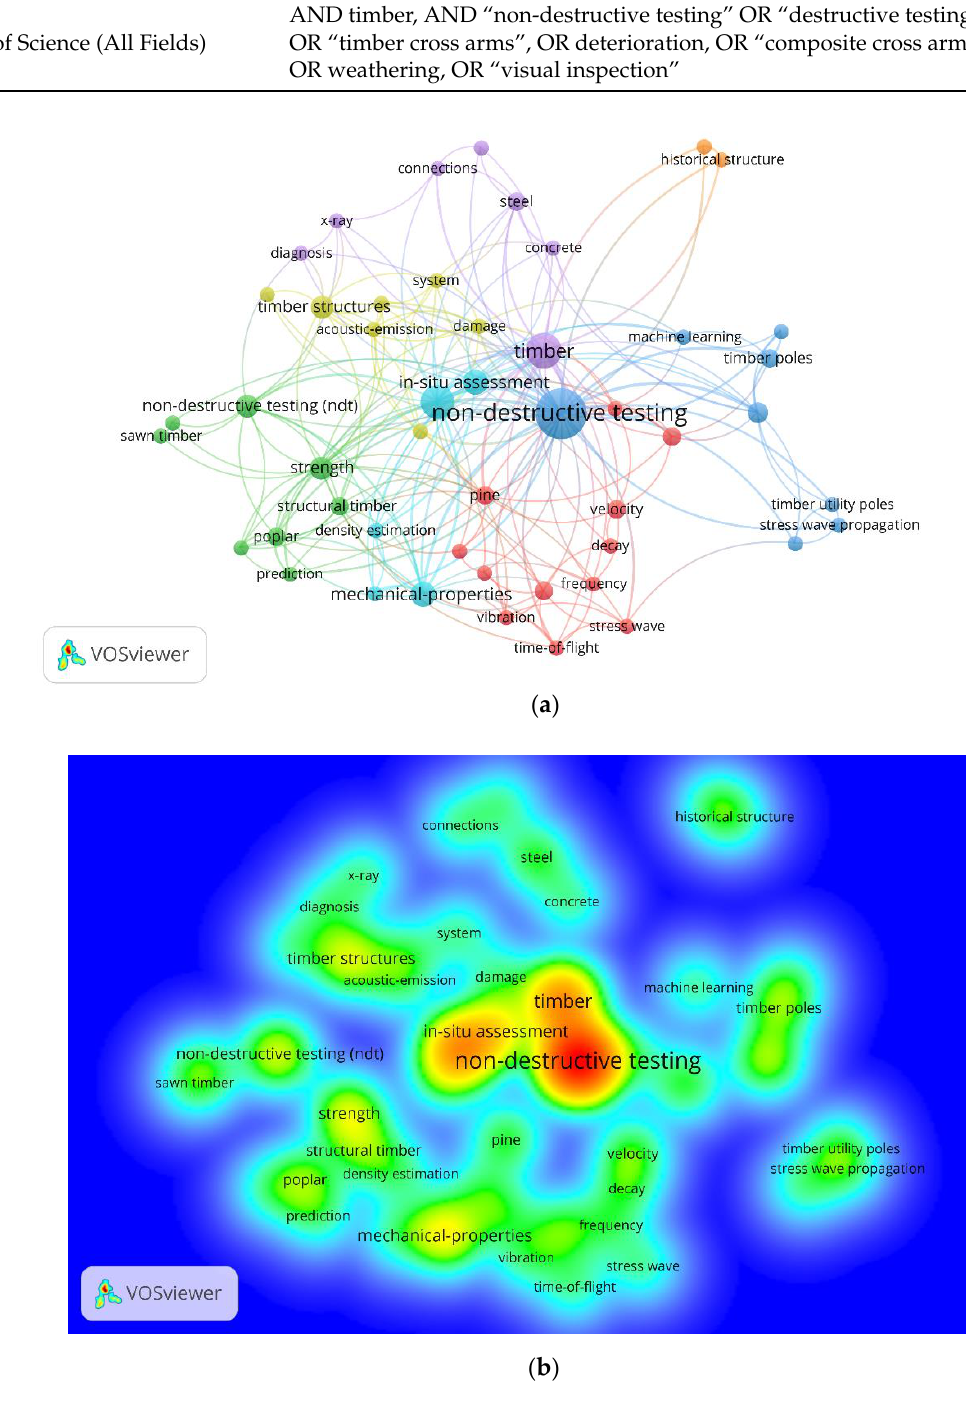
Figure 2. Co-occurrences of keywords. ( a ) Network visualization diagram. ( b ) Density visualization diagram.